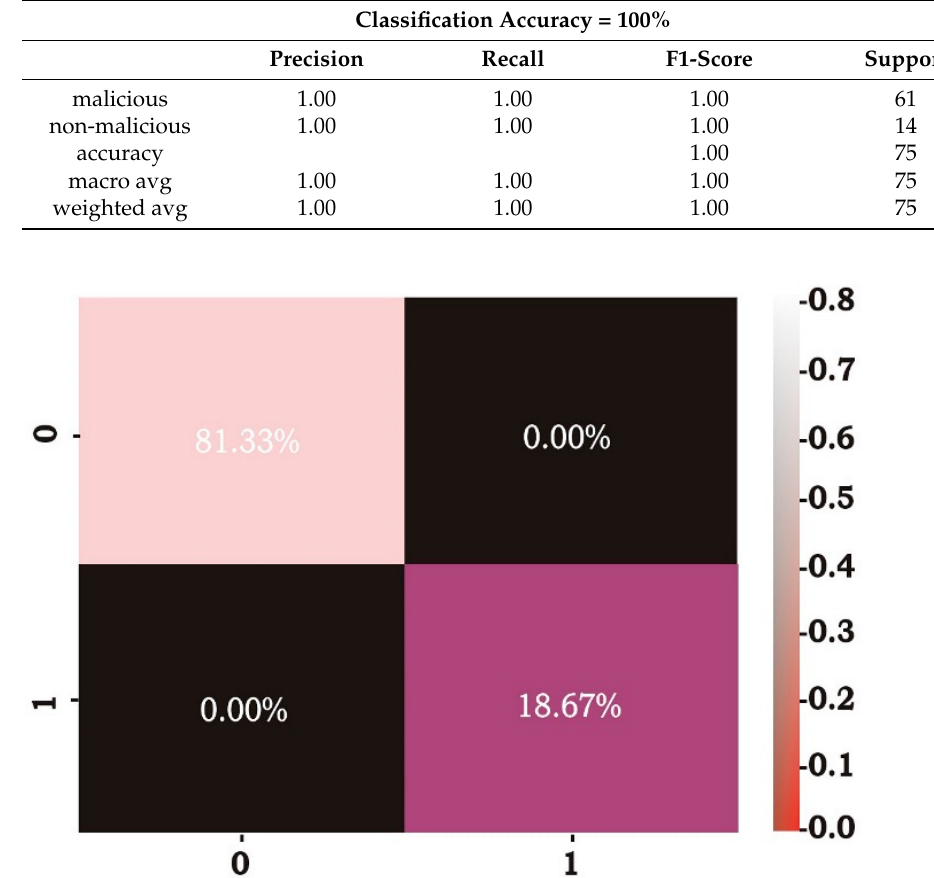
Figure A8. Gaussian NB classifier model summary with a confusion